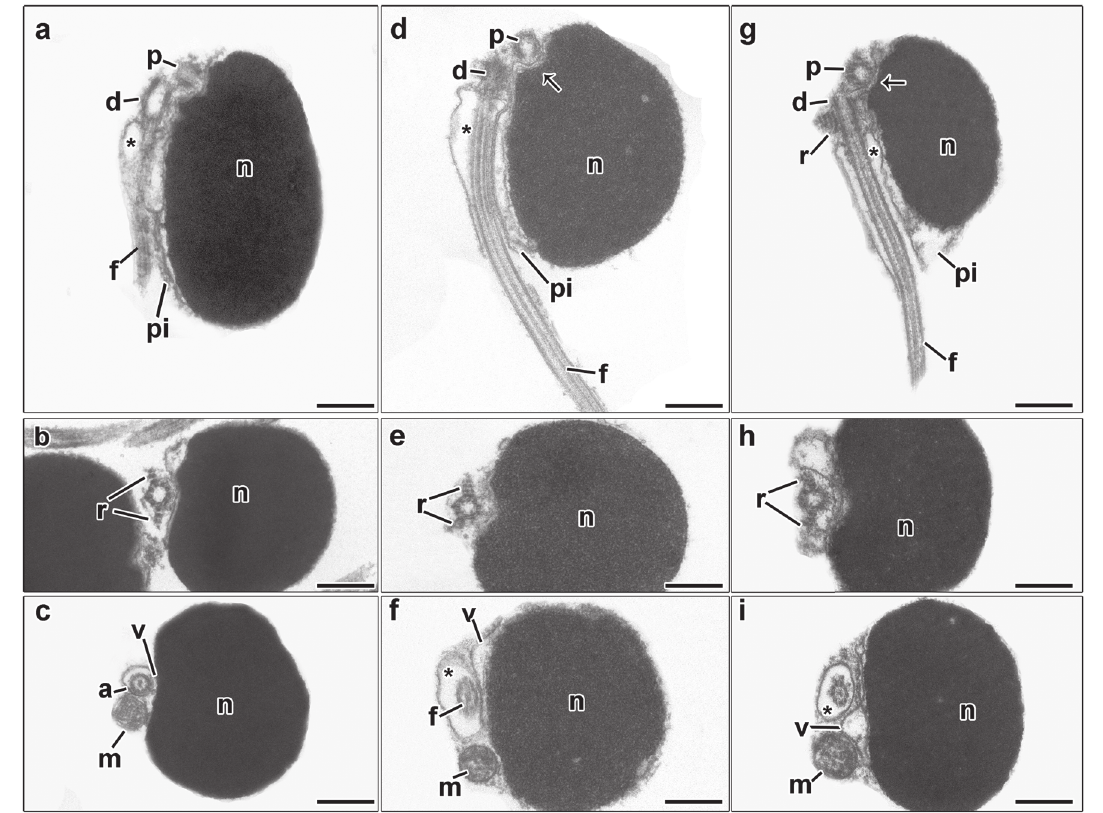
Fig. 3. Spermatozoon of Lebiasina melanoguttata ( a, b, c ), L. aff. uruyensis 1 ( d, e, f ) and L . aff. uruyensis 2 ( g, h, i ). a, d, g : longitudinal sections. b, c, e, f, h, i : transverse sections from top to posterior region. The nucleus (n) of all species is drop- shaped and slightly elongated towards the flagellar axis. The flagellum (f) lies lateral to the nucleus. The centriolar complex (p, d) and nuclear fossa (arrow) is superolateral. Note the presence of the striated rootlets (r) on opposite sides of the distal centriole (d). The proximal centriole (p) is slightly oblique relative to the distal centriole (d) (a-inset, d-inset, g-inset). The cytoplasmic canal is present (asterisk). The midpiece (pi) is short, asymmetrical, and contains the oblong mitochondria (m) and vesicles (v). a: axoneme, d: distal centriole, f: flagellum, m: mitochondria, n: nucleus, p: proximal centriole, r: striated rootlet, v: vesicle, asterisk: cytoplasmic canal, arrow: nuclear fossa. Bar = 0.5 μ